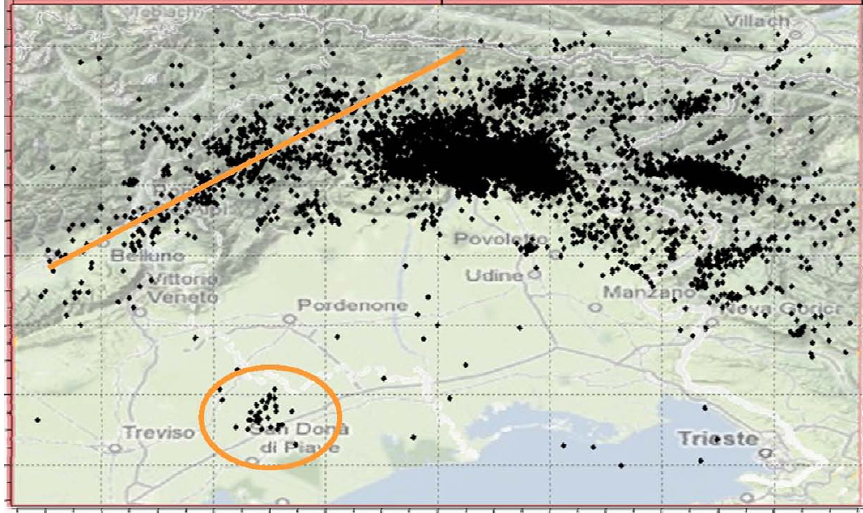
Figure 8. Epicenters estimated using the Hypo71 algorithm. The orange lines highlight patterns to be compared with the corresponding ones in Figure 9.